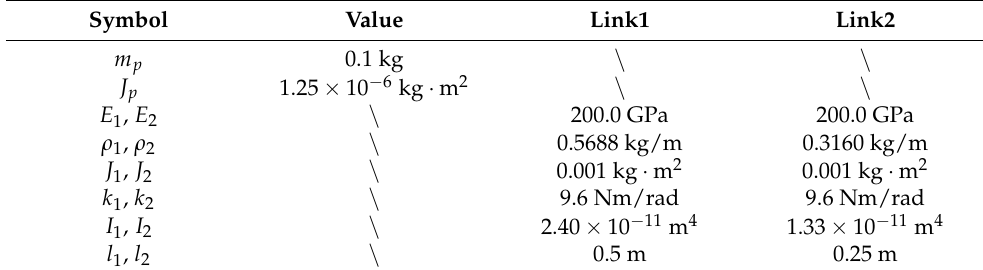
Figure 12. Membership function of input variable